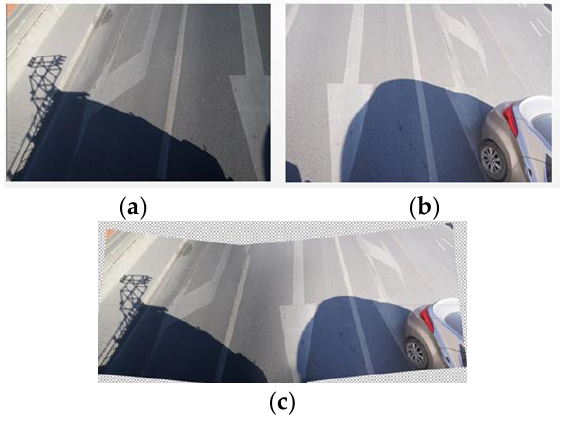
Figure 3. Obtained and fused ground images. ( a ) Ground image obtained by the left cameras. ( b ) Ground image obtained by the right cameras. ( c ) Fused ground image.